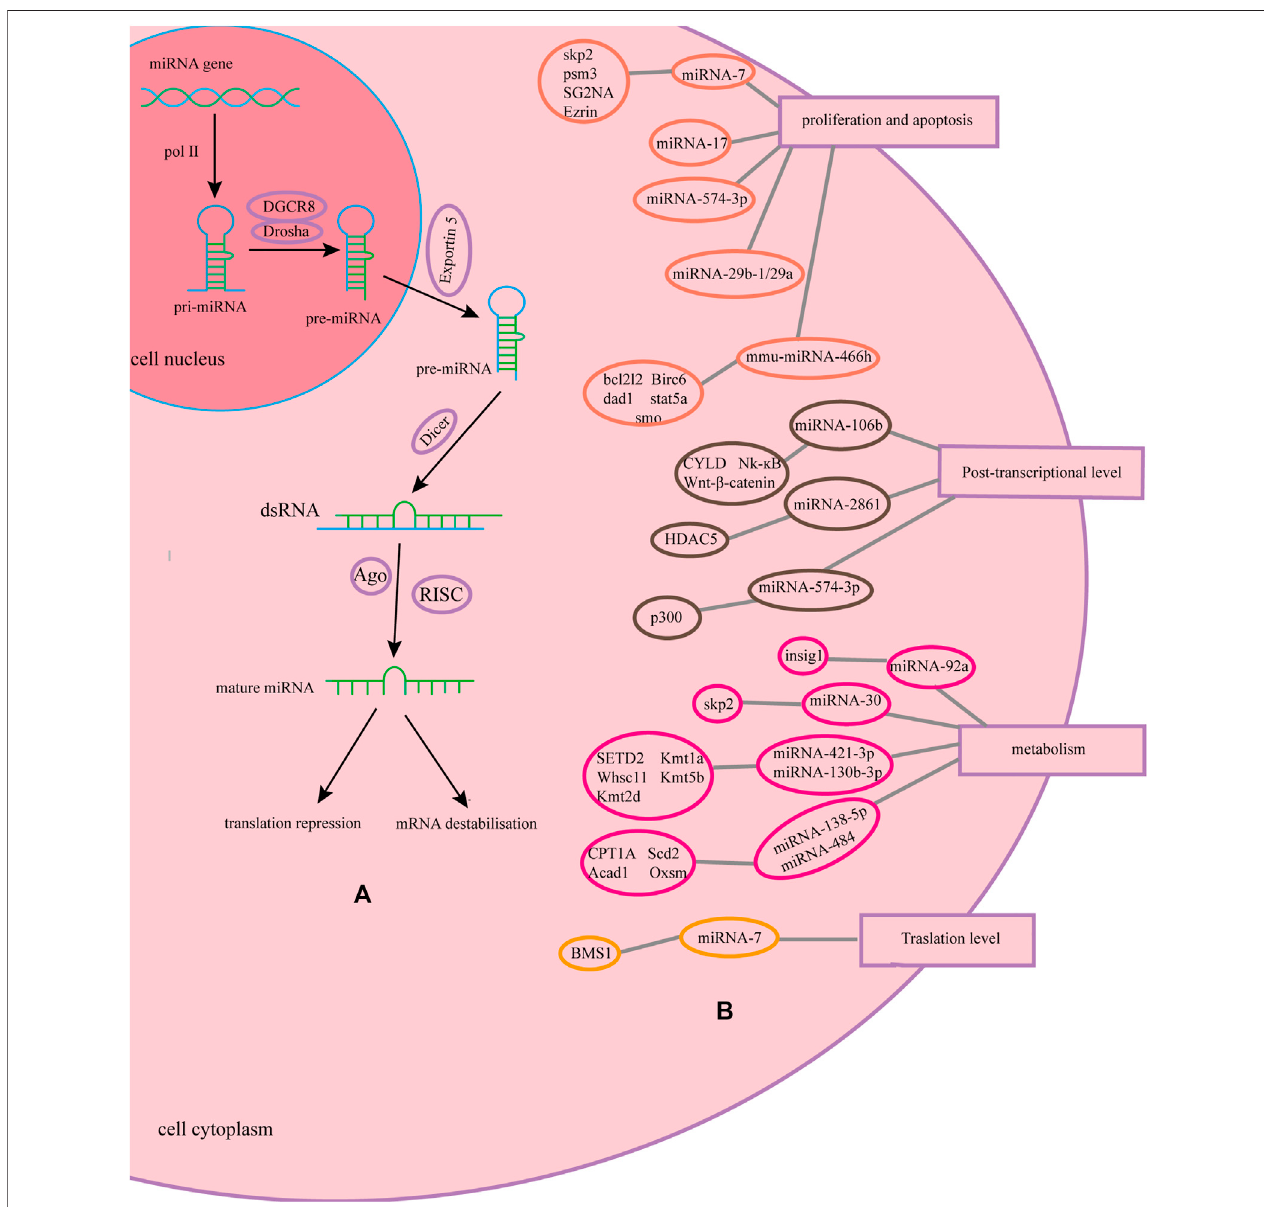
FIGURE1| BiologicalprocessandfunctionofmiRNAanditsmechanism. (A) BiologicalprocessofmiRNAanditsmechanism. (B) ThemechanismsofmiRNAson recombinant protein in CHO cells.